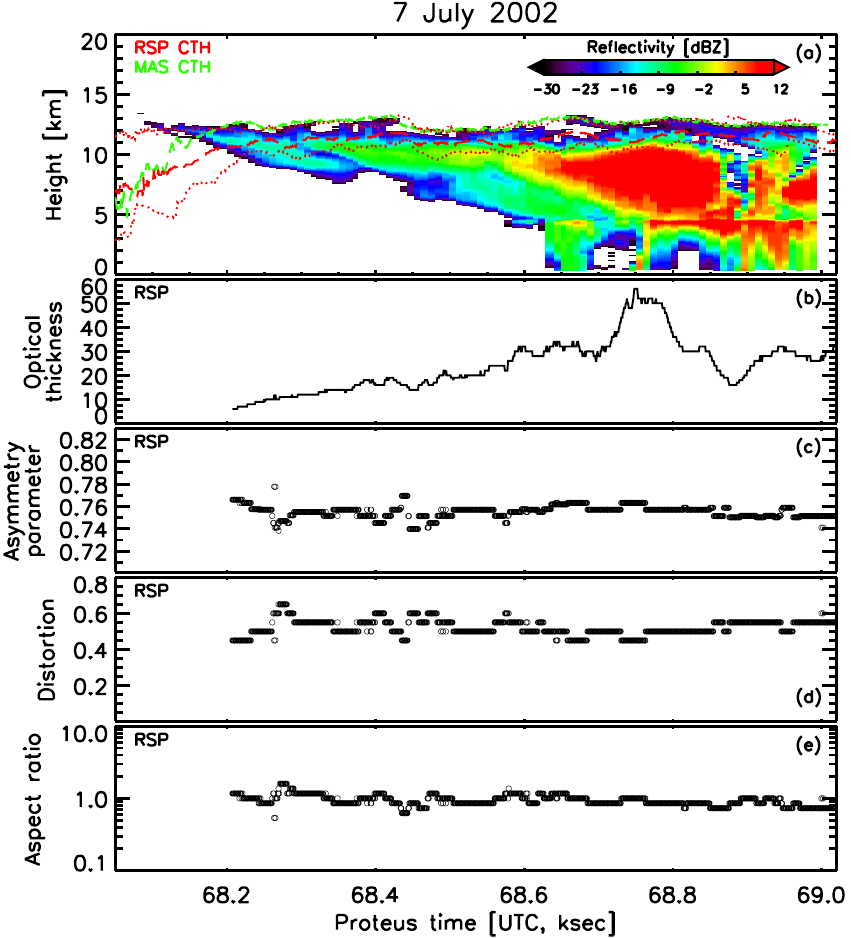
Fig. 6. Same as Fig. 3 but for 7 July and without CIN retrievals.